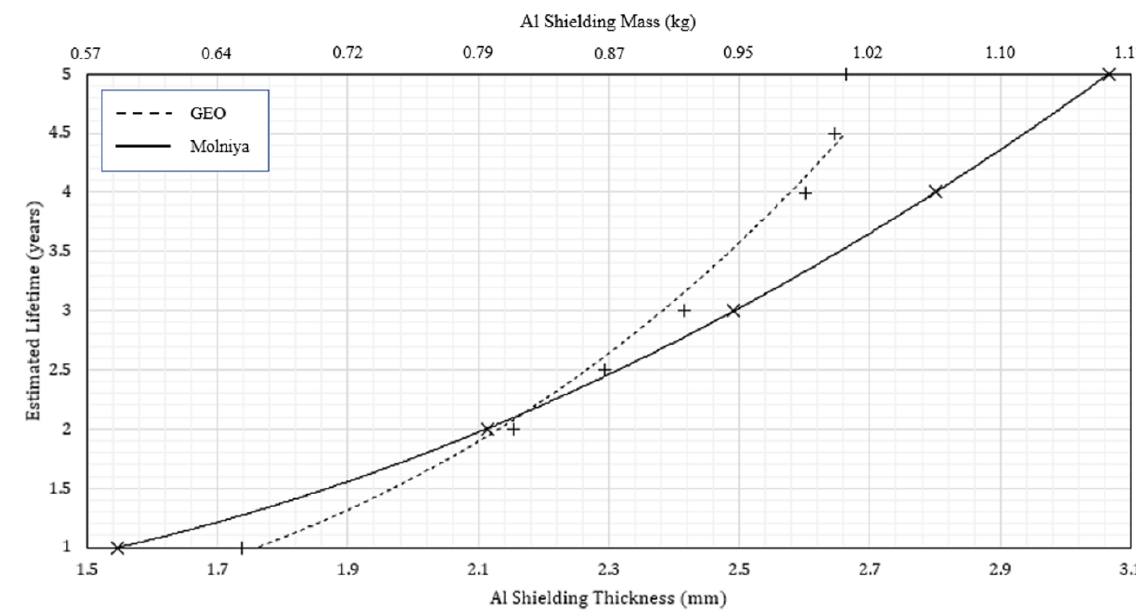
Figure 21. Estimated Lifetime (time to receive TID of 30 krad) in GEO and Molniya as a function of shielding thickness and the equivalent mass for the 10 × 10 × 30 cm surface area of a 3U CubeSat.